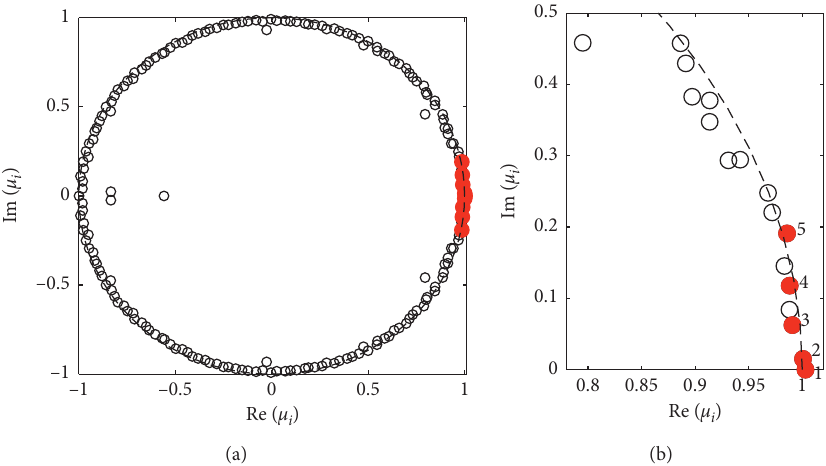
Figure 6: Distribution of eigenvalues of 200hPa jet: open circles represent full DMD eigenvalues; filled circles that are numbered with 1–5 are the modes isolated by the SPDMD: (a) full spectrum, (b) zoom on the isolated modes. Table 1: Growth rate and frequency of the five SPDMD modes of the 200hPa jet flow field. DMD